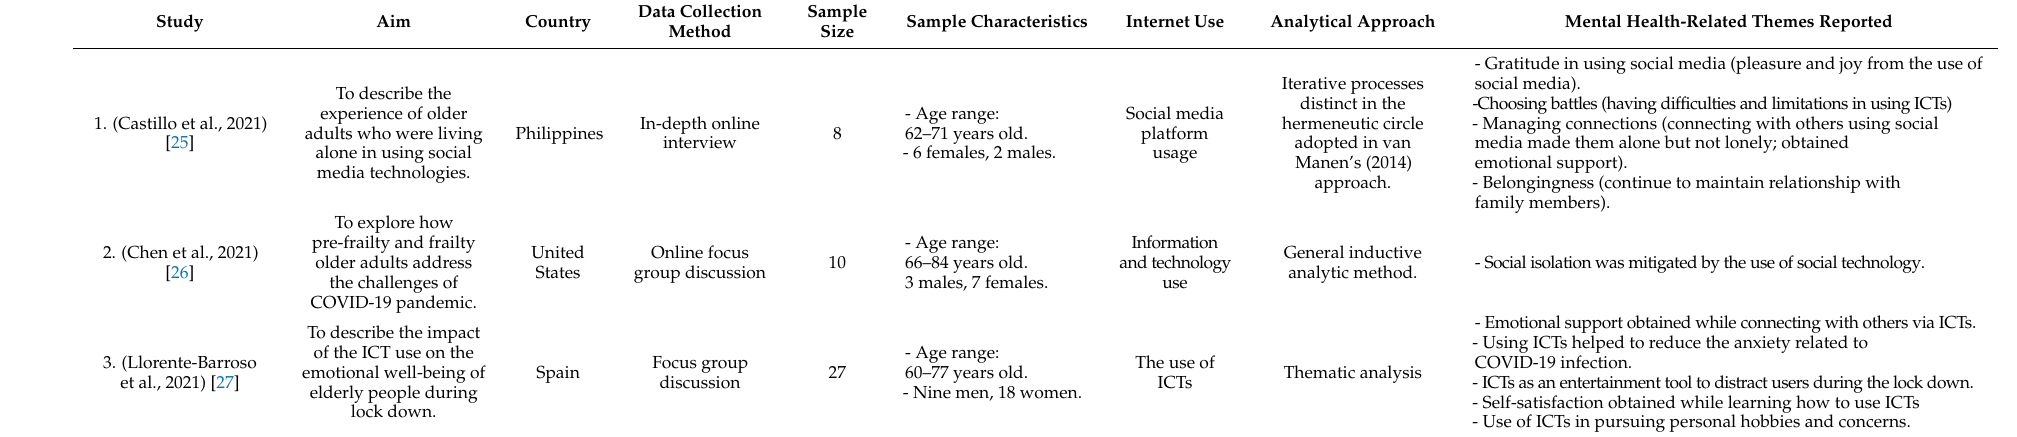
Table 4. Summary of qualitative